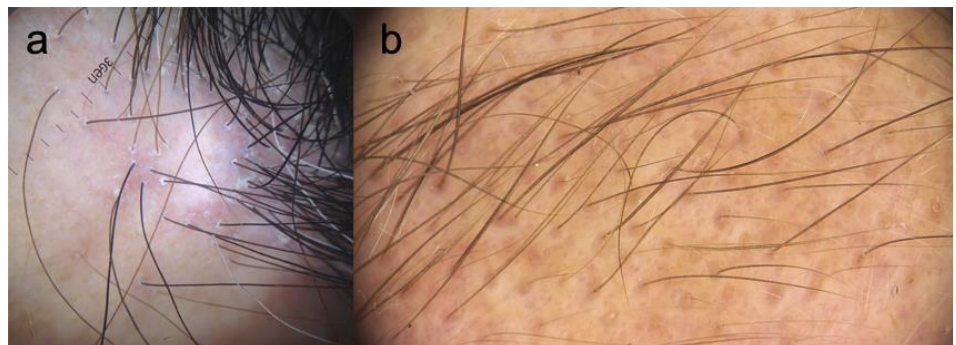
Figure 4. ( a ) Frontal hairline: perifollicular erythema and hyperkeratosis, follicles with one hair shaft, white patches, and loss of follicular openings. ( b ) Eyebrows: partial alopecia with red follic- ular